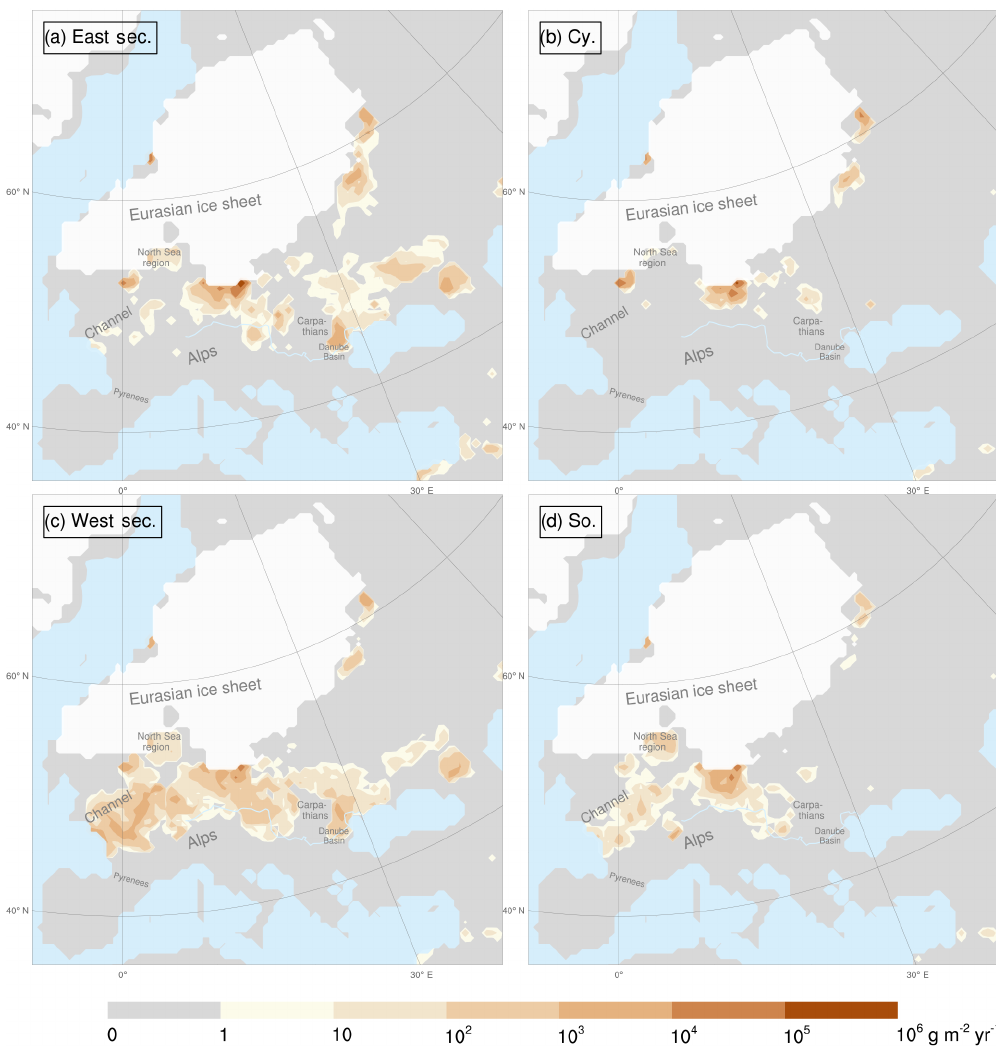
Figure 8. Dust emission rate fractions caused by the (a) northeasters, easterlies, and southeasters; (b) cyclonic regimes; (c) southwesters, westerlies, and northwesters; and (d) southerlies during the Last Glacial Maximum. The simulated emission rates are weighted according to the occurrence frequency of the associated wind regime(s) in the Max Planck Institute Earth System Model (Table 2). Dust particles up to 20µm in diameter have been considered. The Danube (light-blue line) and the extent of the continental ice sheets (white) are